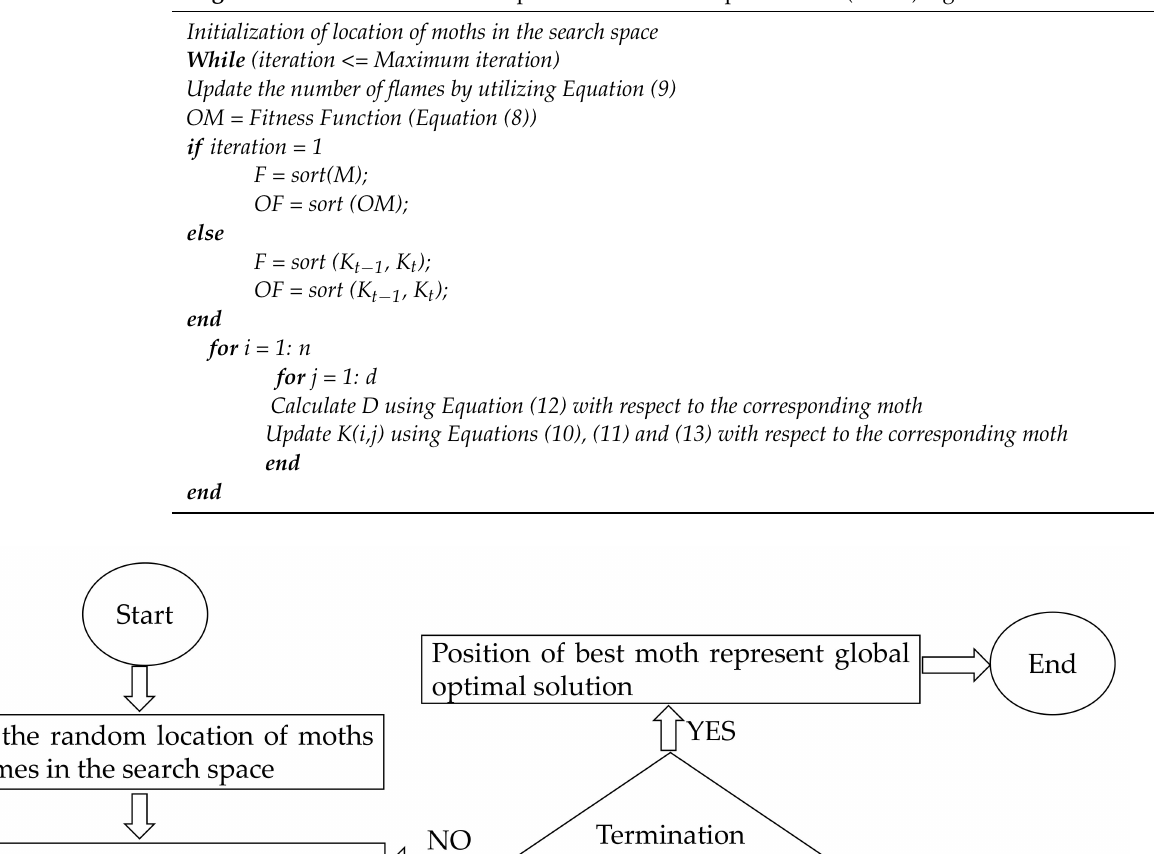
Algorithm 1. Pseudo-code for improved moth flame optimization (IMFO) algorithm.